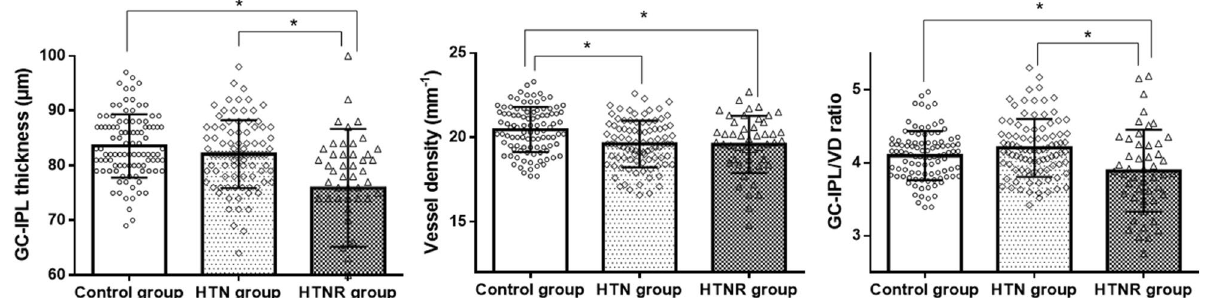
Figure 2. Bar graphs with scatter plots showing the average ganglion cell-inner plexiform layer thickness (GC-IPL), vessel density (VD), and GC-IPL/VD ratio in each group. *Statistically significant